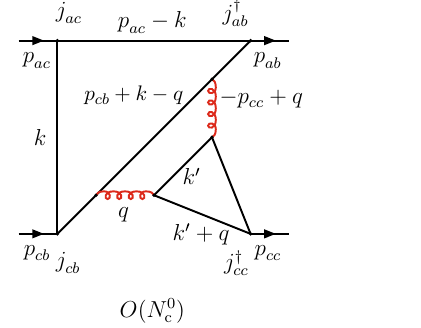
Fig. 23 A diagram of the recombination channel of the cryptoexotic case with two-gluon exchanges